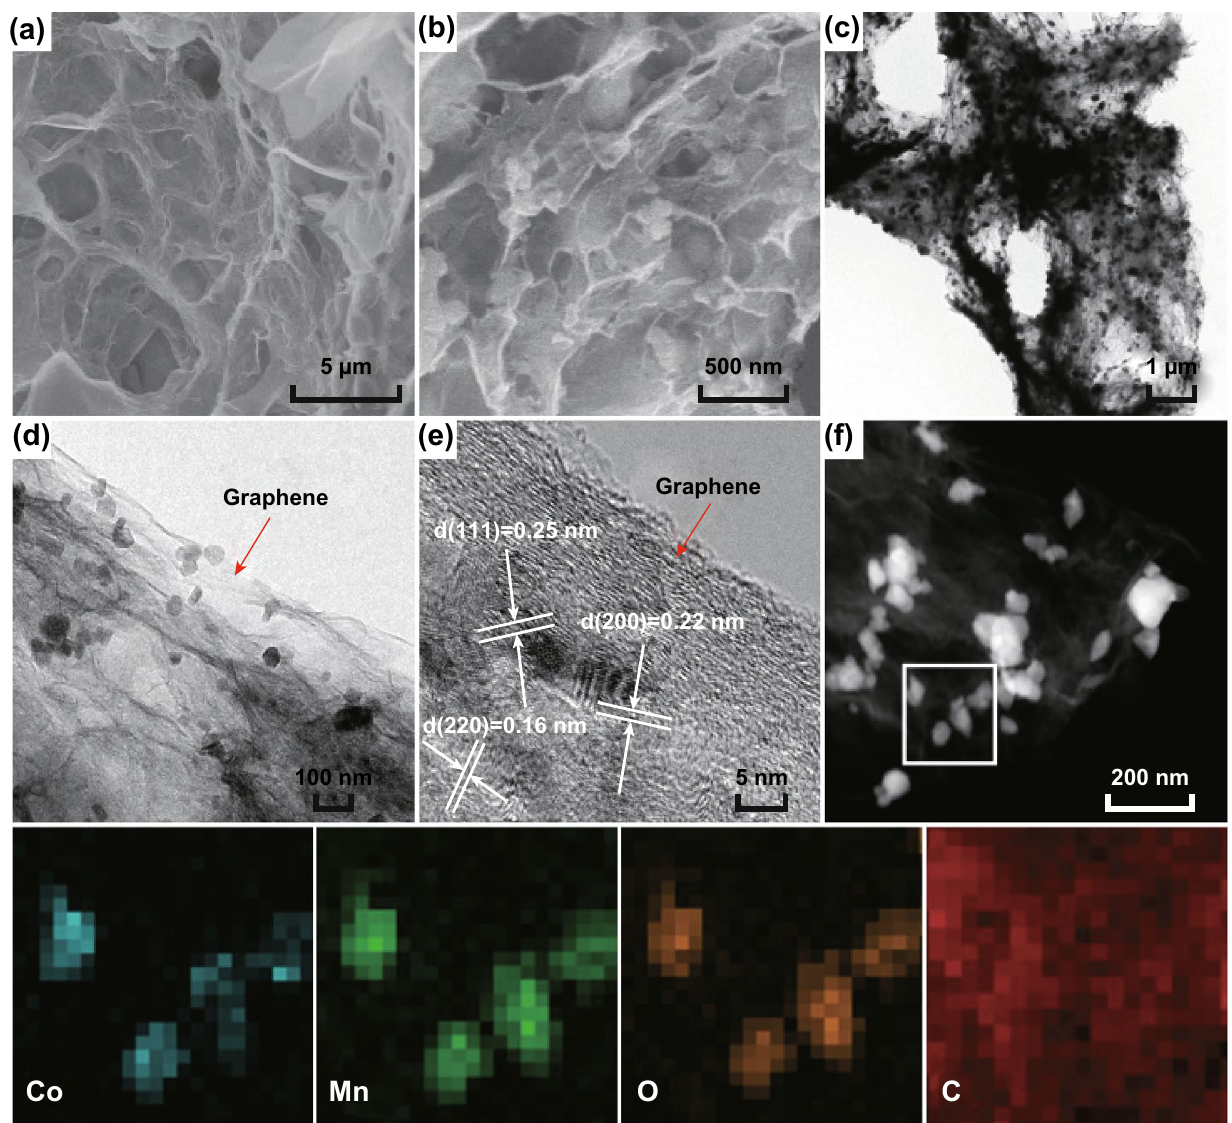
Fig. 2 a , b SEM and c , d TEM images of MnO/CoMn 2 O 4 ⊂ GN. e High-magnification TEM image of MnO/CoMn 2 O 4 ⊂ GN. f The correspond- ing elemental mapping images of the MnO/CoMn 2 O 4 ⊂ GN for Co, Mn, O, and